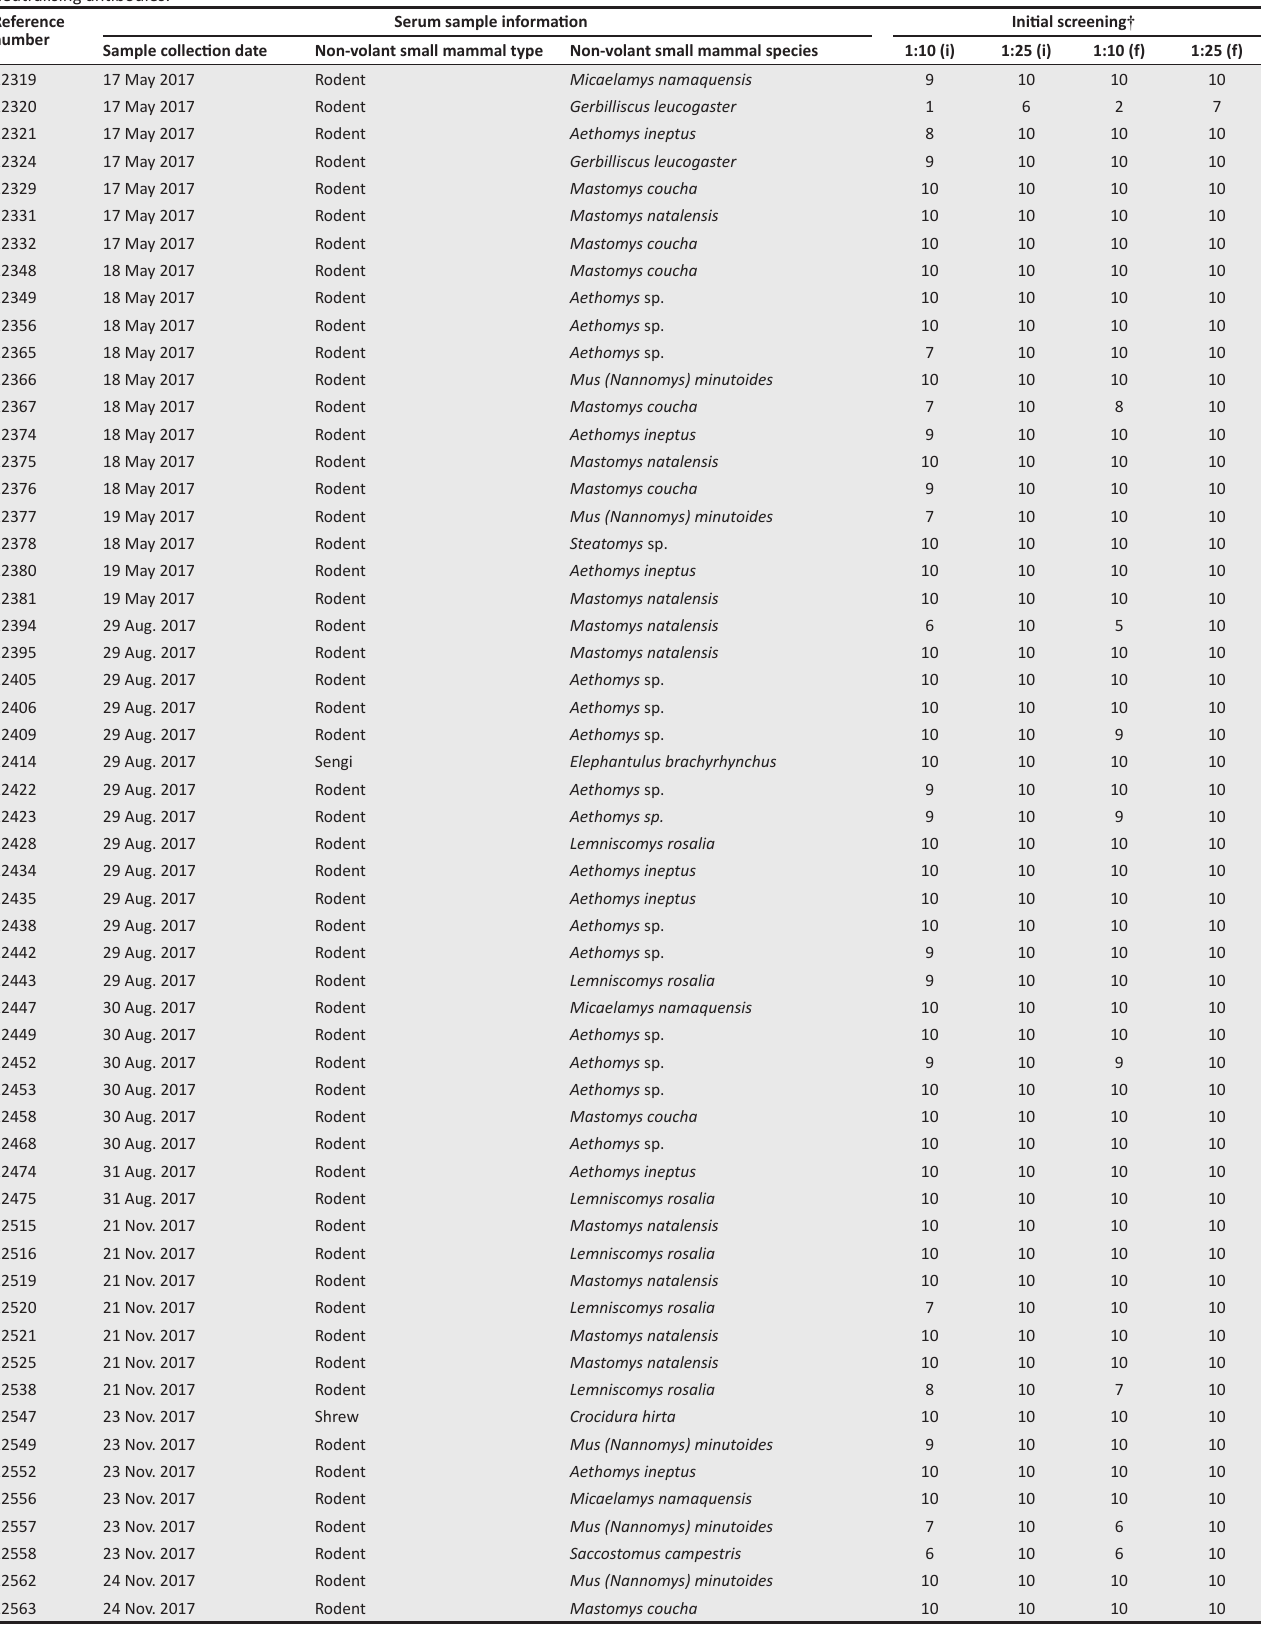
TABLE 4-A1 (Continues...): Micro-neutralisation test results of all non-volant small mammal serum samples that tested negative for the presence of Mokola virus neutralising antibodies. Reference